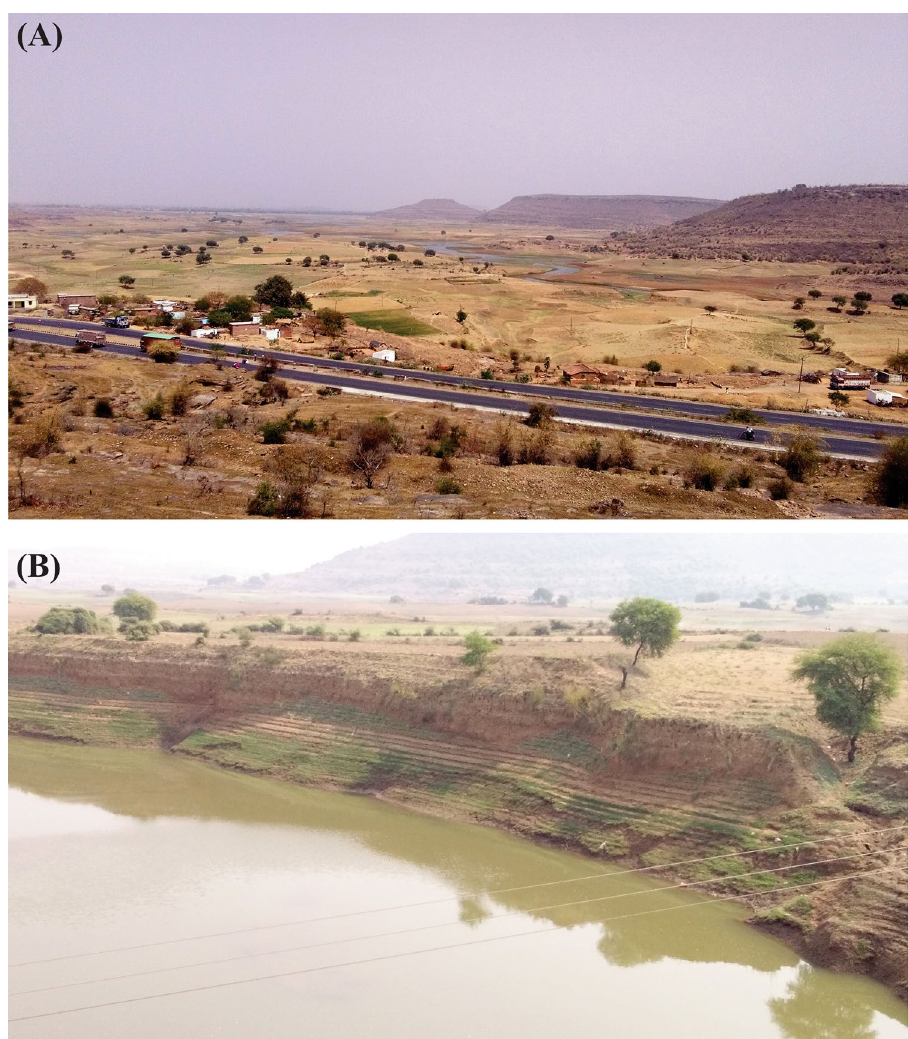
(Fig. 1) are filled by interpolation techniques and sink fill algorithm applied as preprocessing of DEM for minimiz- ing errors.